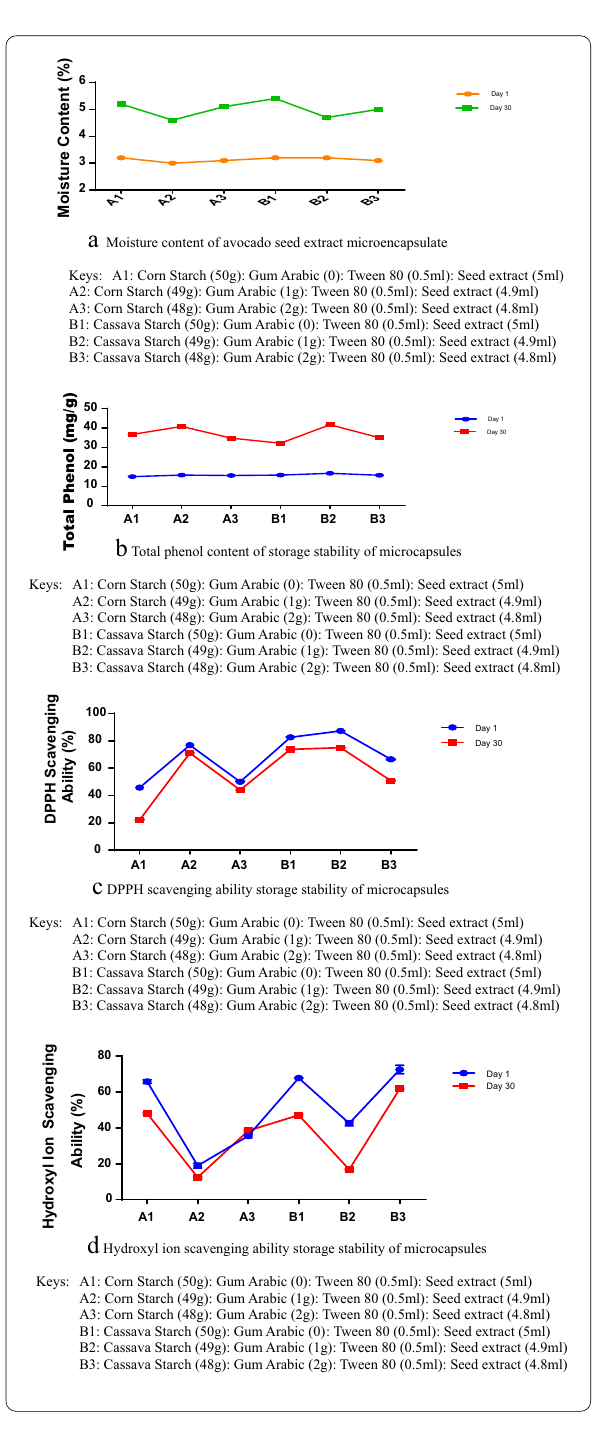
Fig. 3 a Moisture content of avocado seed extract microencapsulate. b Total phenol content of storage stability of microcapsules. c DPPH scavenging ability storage stability of microcapsules. d Hydroxyl ion scavenging ability storage stability of microcapsules. Keys: A1: Corn Starch (50 g): Gum Arabic (0): Tween 80 (0.5 ml): Seed extract (5 ml). A2: Corn Starch (49 g): Gum Arabic (1 g): Tween 80 (0.5 ml):